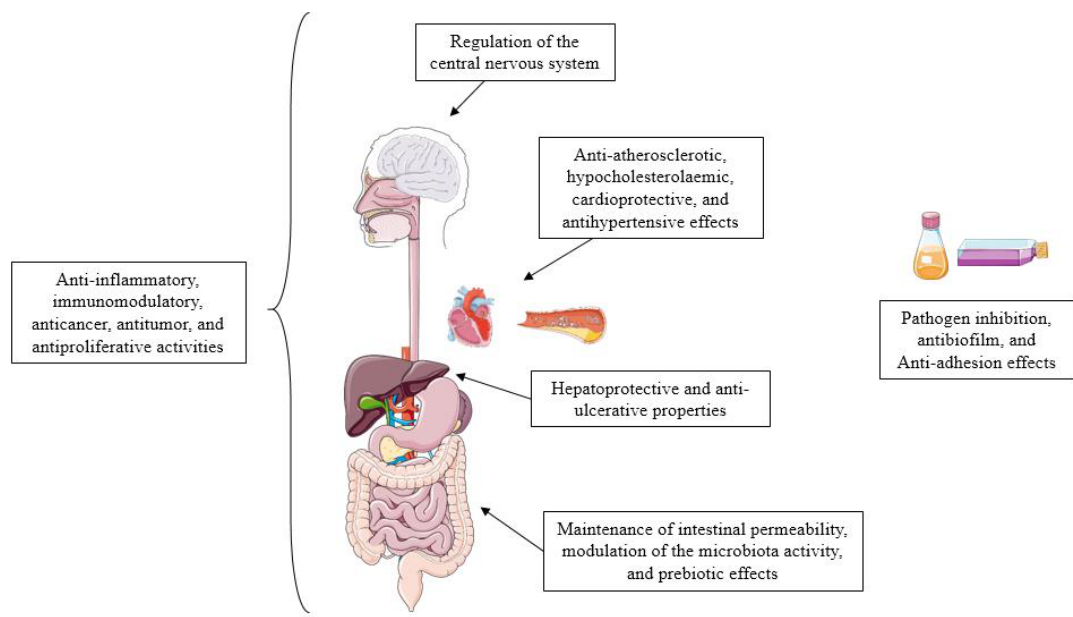
Figure 3. Potential mechanisms of action of postbiotics (illustrations from Smart ® ).